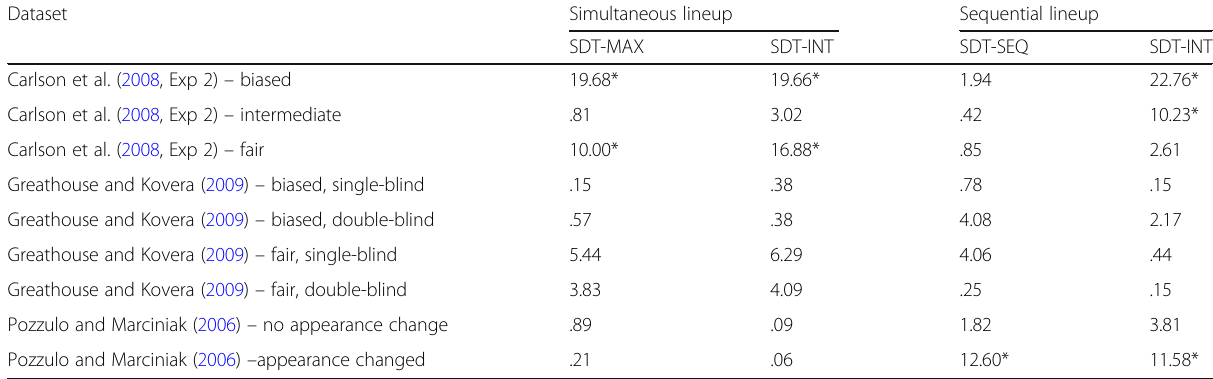
Table 2 Chi-square fit values for previously non-fitting datasets, disaggregated in to original experimental conditions